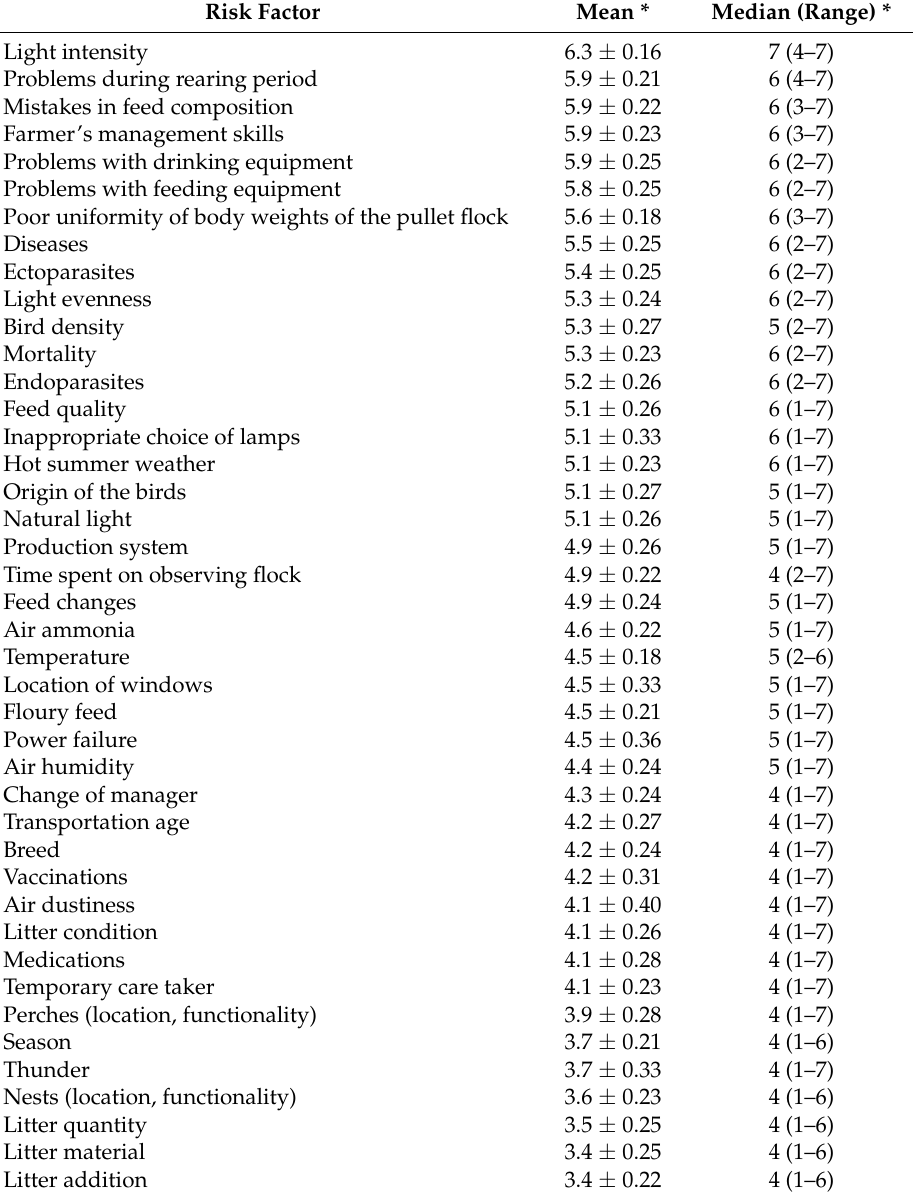
Table 3. The importance of risk factors for pecking-related problems in laying hens, detailed by Finnish egg